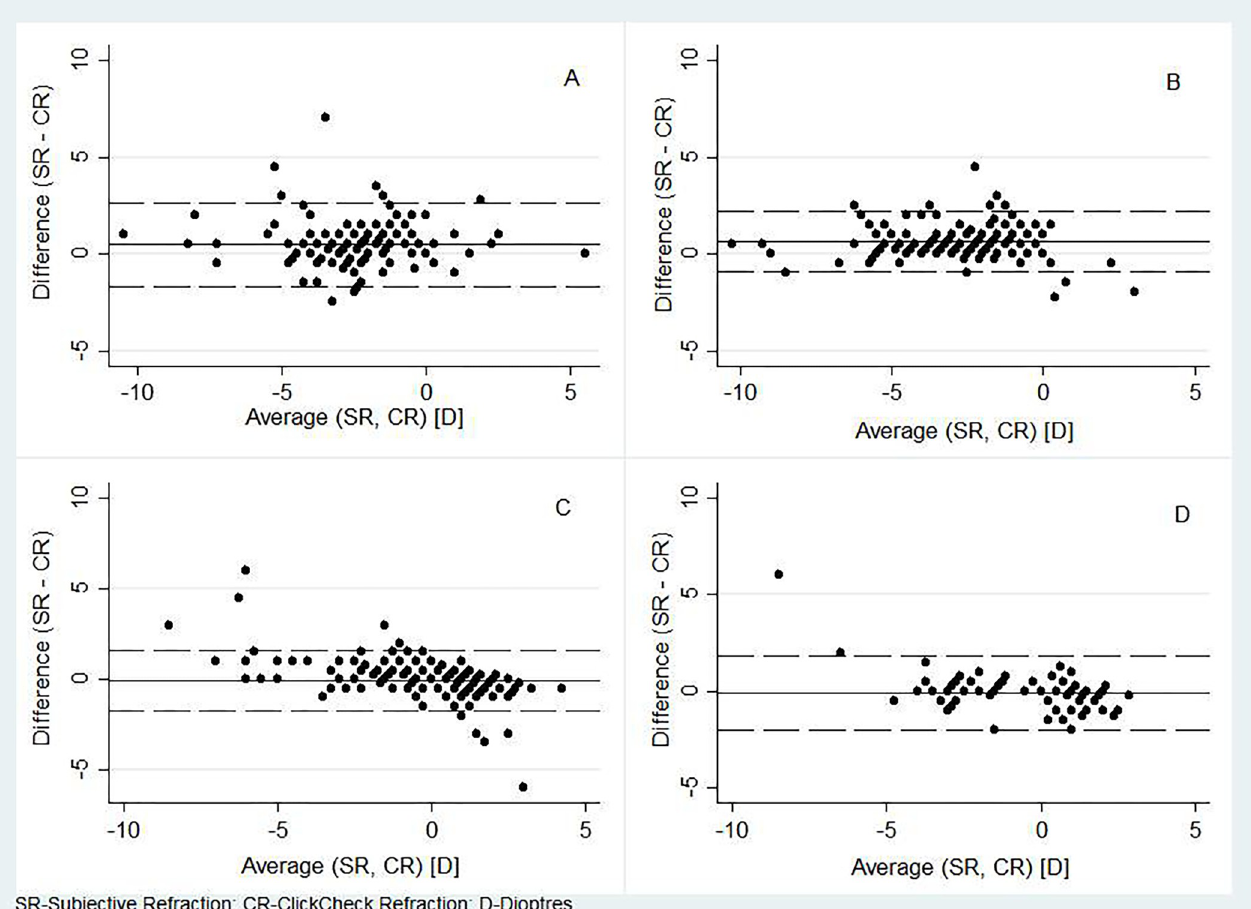
Fig 5. Bland Altman plot comparing the agreement of measurements by subjective refraction (SR) and ClickCheck TM refraction (CR) across different age categories A) 7 to 15 years, B) 16 to 40 years, C) 41 to 59 years, D) 60 to 70 years.